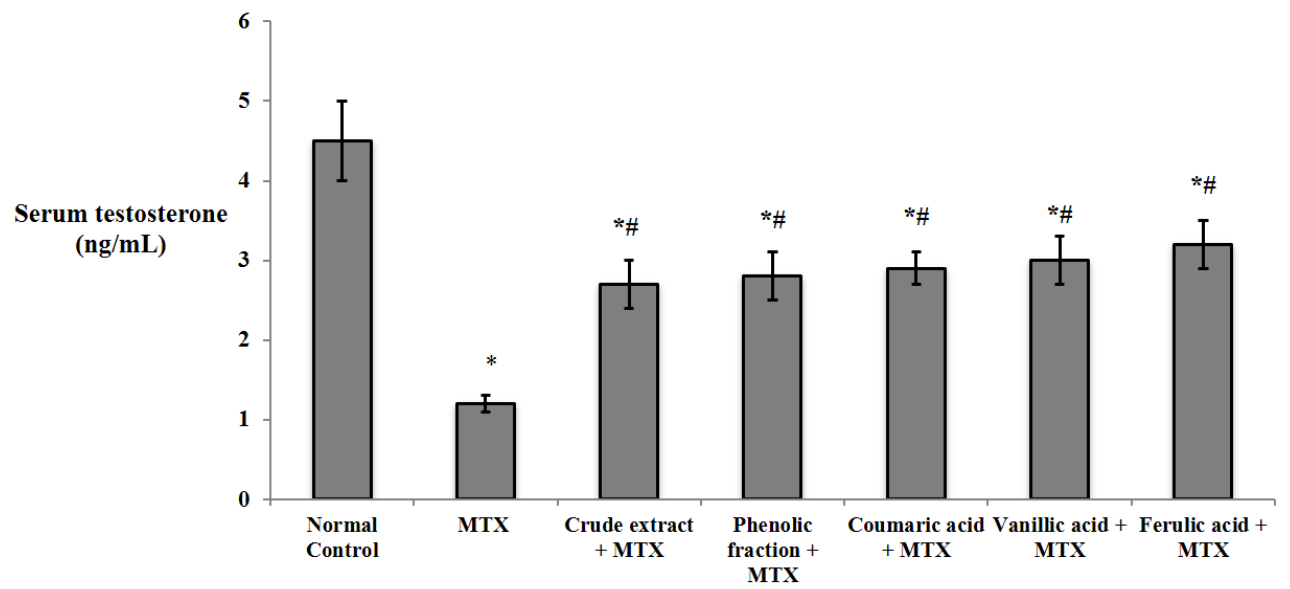
Figure 5. Effects of C. endivia L. crude extract, phenolic fraction, and its isolated compounds (coumaric, vanillic, and ferulic acids) on the serum level of testosterone in the experimental mice. Data are expressed as the mean ± SD. Data were analyzed using one-way ANOVA followed by Bonferroni’s post hoc test. * Significant against normal control group, # significant against MTX control group. Values were considered significantly different at p < 0.05.